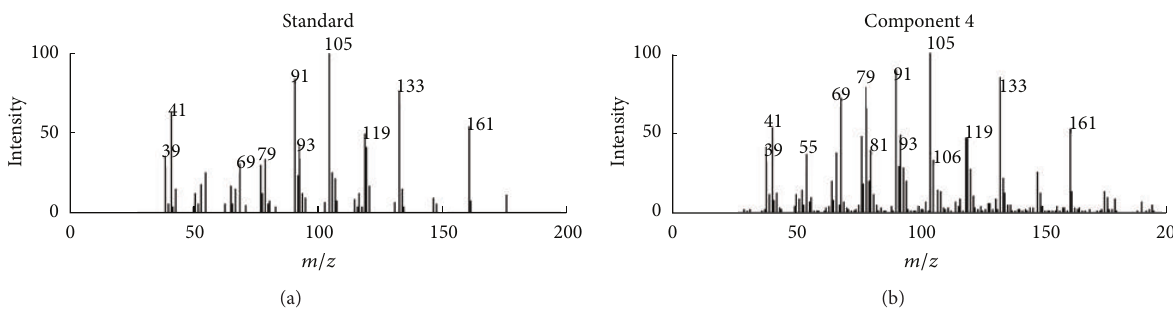
Figure 5: Resolved mass spectrum of component 4 by SFA and standard mass spectrum of 2-cyclopropylidene-1,7,7-trimethyl-bicyolo[2,2,1] heptane.